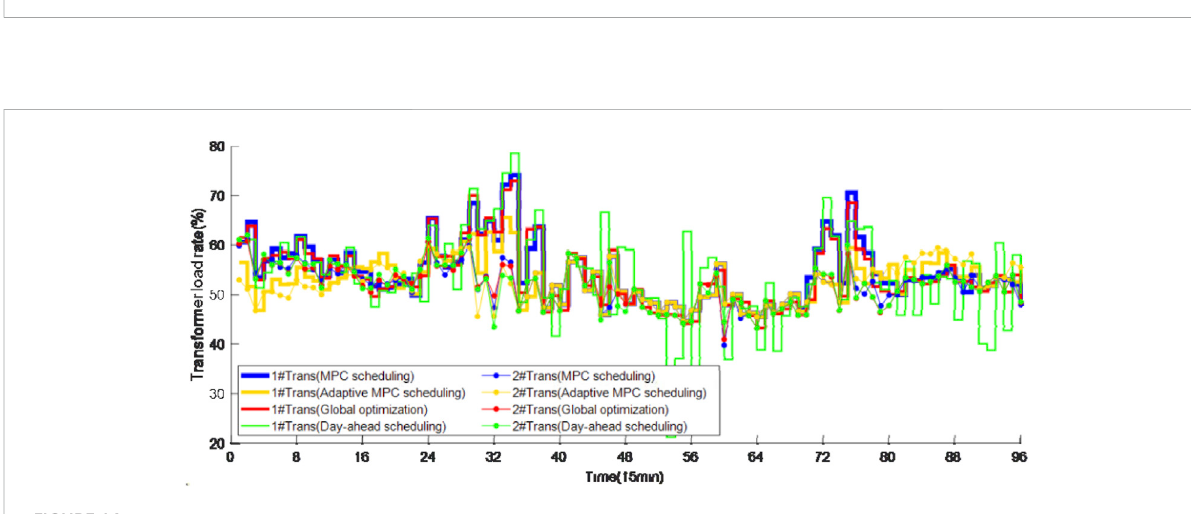
FIGURE 14 Loading rate curves of the transformers under different scheduling